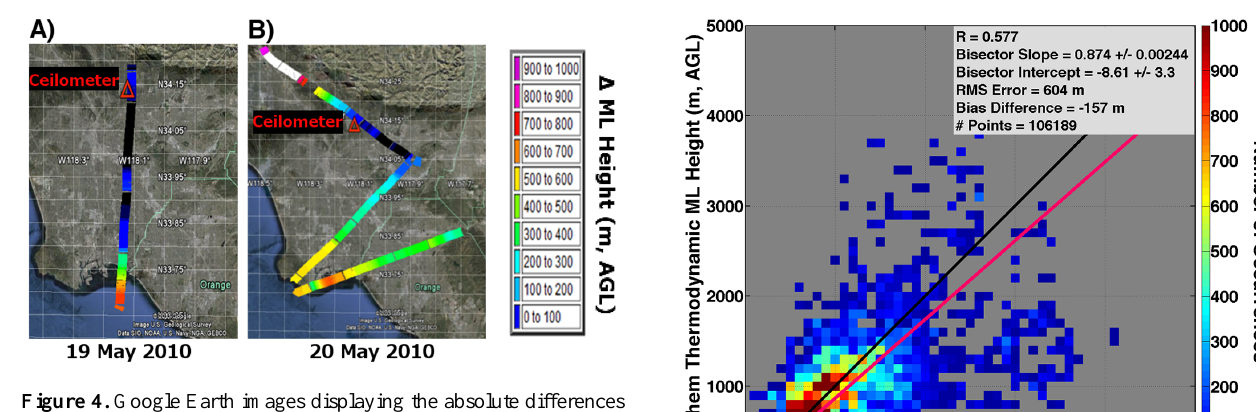
Figure 4. Google Earth images displaying the absolute differences between the HSRL and ceilometer aerosol ML heights in meters for portions of two flights during CalNex ( 1 ML Height=HSRL- ceilometer). (A) Data on 19 May were taken from approximately 14:00 to 14:10LST; (B) data on 20 May were taken from approxi- mately 12:45 to 13:15LST.